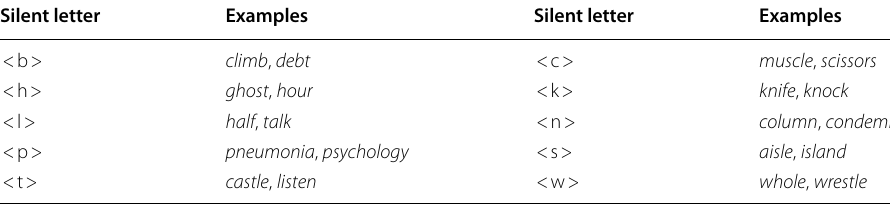
Table 1 Examples of English words written with one or more silent letters Silent